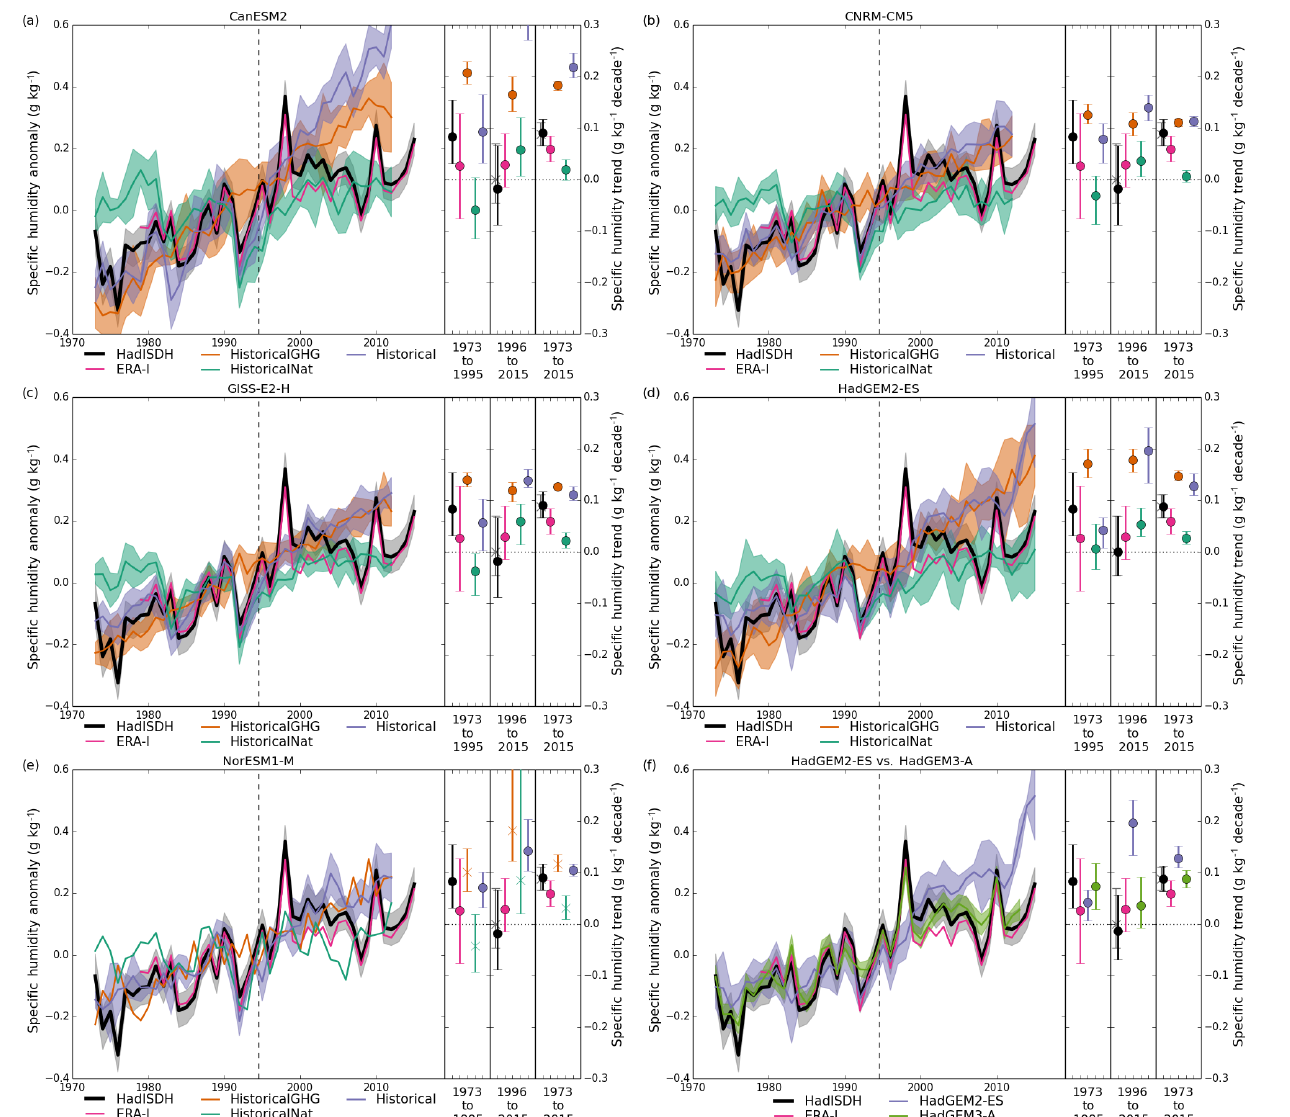
Figure 3. Global annual time series for specific humidity for five of the nine CMIP5 models and HadGEM3-A using a climatology period of 1976–2005. HadISDH is shown by the thick black line, ERA-Interim by the magenta line, and the historical, historicalNat, and historicalGHG ensemble averages by the purple, green, and orange lines respectively. The uncertainty ranges are shown using the coloured shading. The three scatter plots in the right-hand side of each panel show the values of the linear trends for HadISDH, ERA-Interim and the ensemble averages of all three experiments for the early (1973–1994), late (1995–2015) and full periods. For the late and full period panels, the HadISDH trend is shown matching the temporal coverage of the historical model (circle) and its full coverage (cross). If there is only one ensemble member for the model, then the trend is marked with a cross rather than